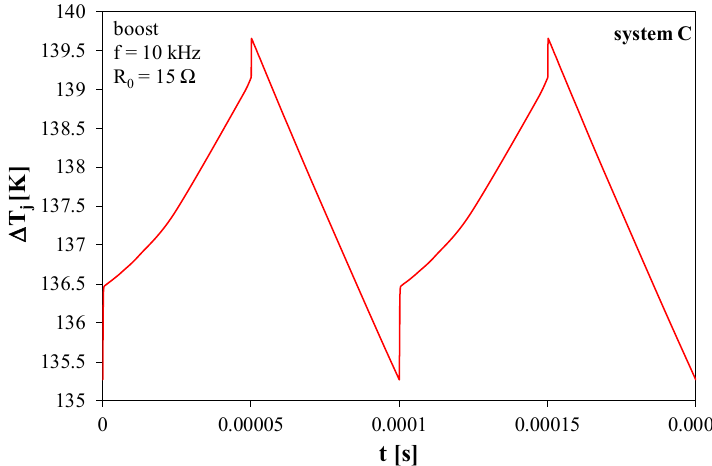
Figure 14. Waveform of the junction temperature at the steady state for the transistor working in the boost converter and cooperating with the cooling system C at frequency f = 10 kHz and load resistance R 0 = 15 Ω .